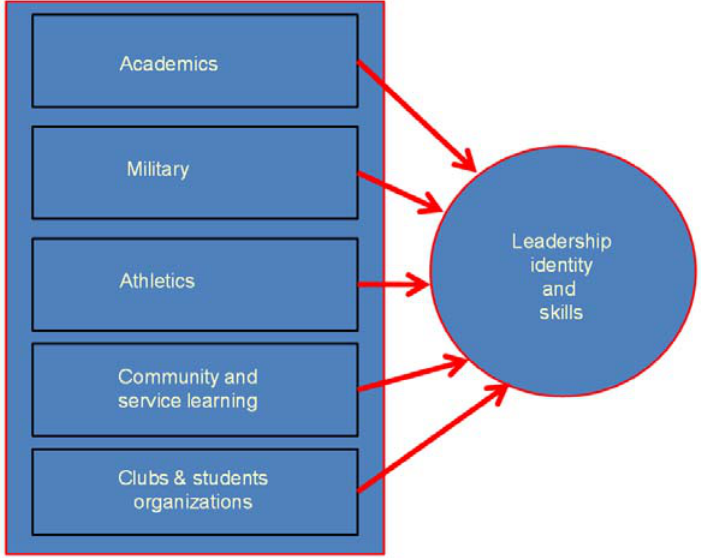
Fig. 4. Leadership development program at the